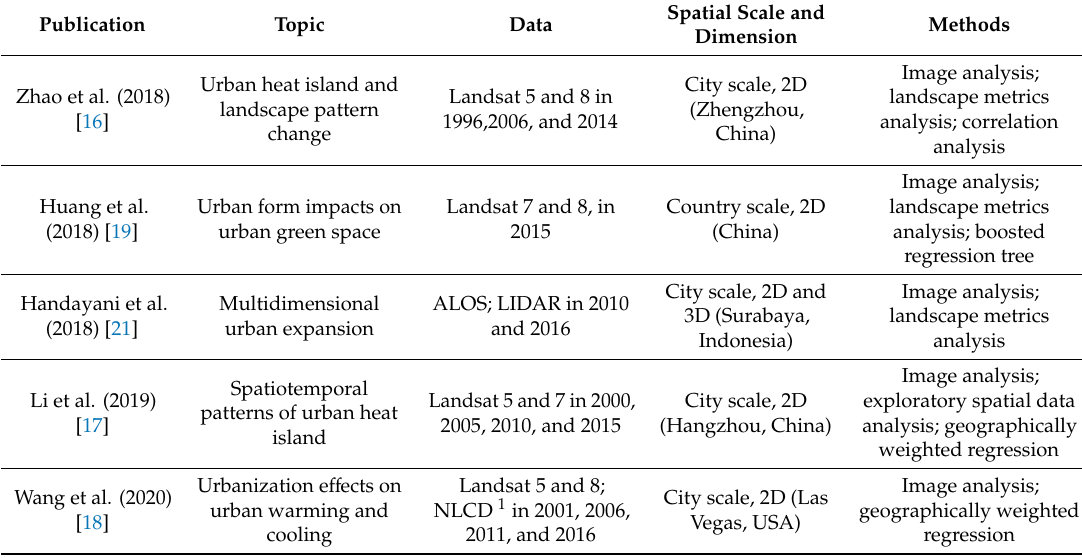
Table 1. Publication summary in the Special